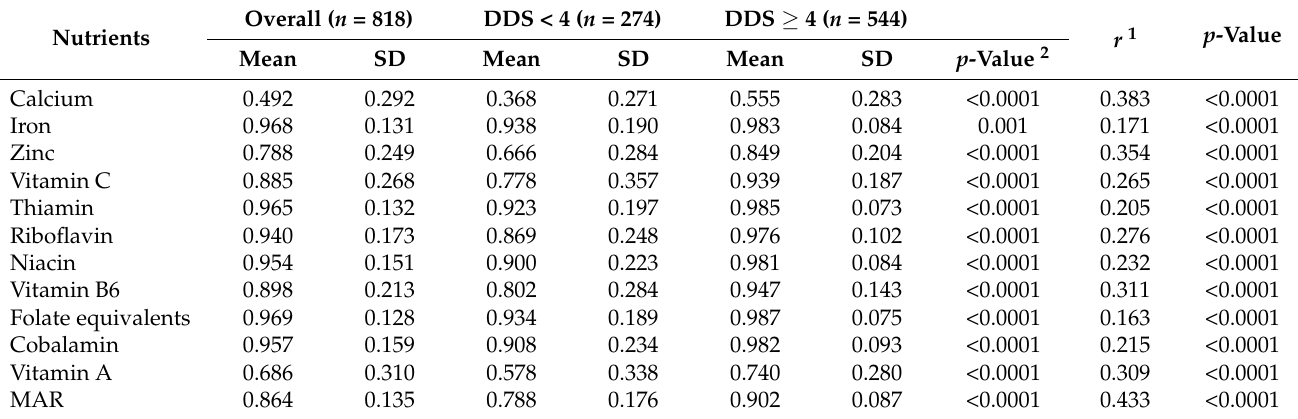
Table 5. Mean Nutrient Adequacy Ratio (NAR), according to Diet Diversity Score